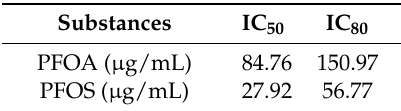
Figure 1. Inhibition rate of PFOS and PFOA in ZFL cells. ZFL cells were treated with 100 µ g/mL, 50, 25, 12.5, 6.25, 3.125, 1.062, 0.53, 0.2605, 0.130, 0.065 or 0 µ g/mL of either PFOA or PFOS for 48 h. The inhibition rate was determined by MTT assay. Table 2. IC 50 and IC 80 of PFOA and PFOS.